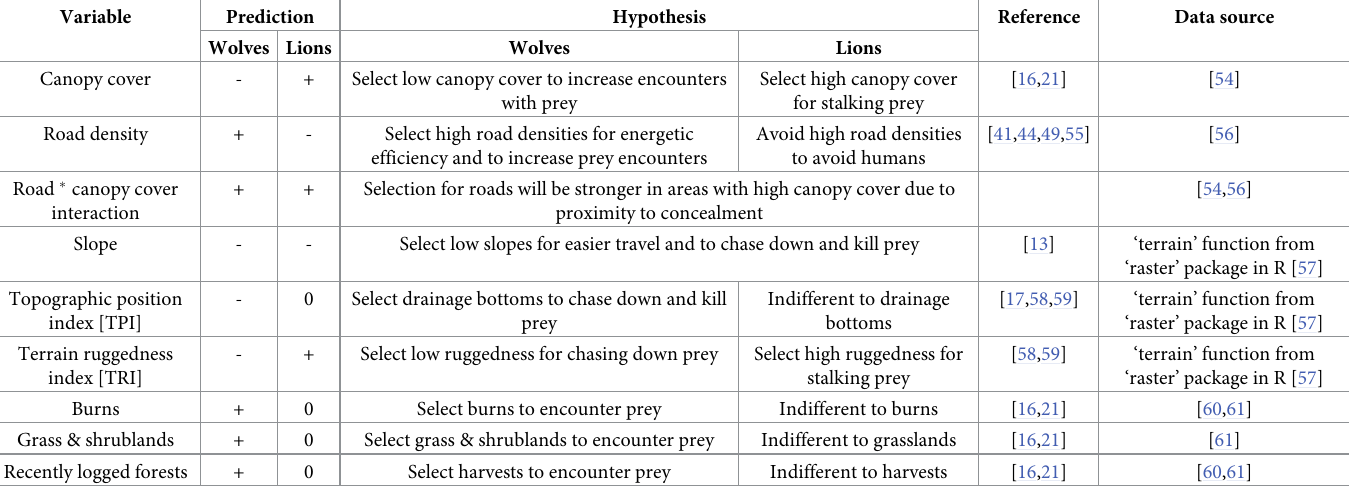
“+” indicates predicted selection for high values of a variable, “-” indicates avoidance and “0” indicates neutrality. Some variables were not tested in both wolf and mountain lion RSFs due to collinearity with other